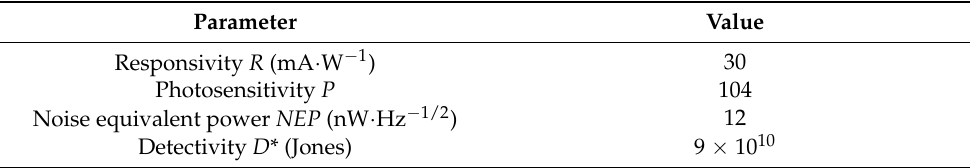
Table 2. Photodetector parameters evaluated for the CuPc OFET device.